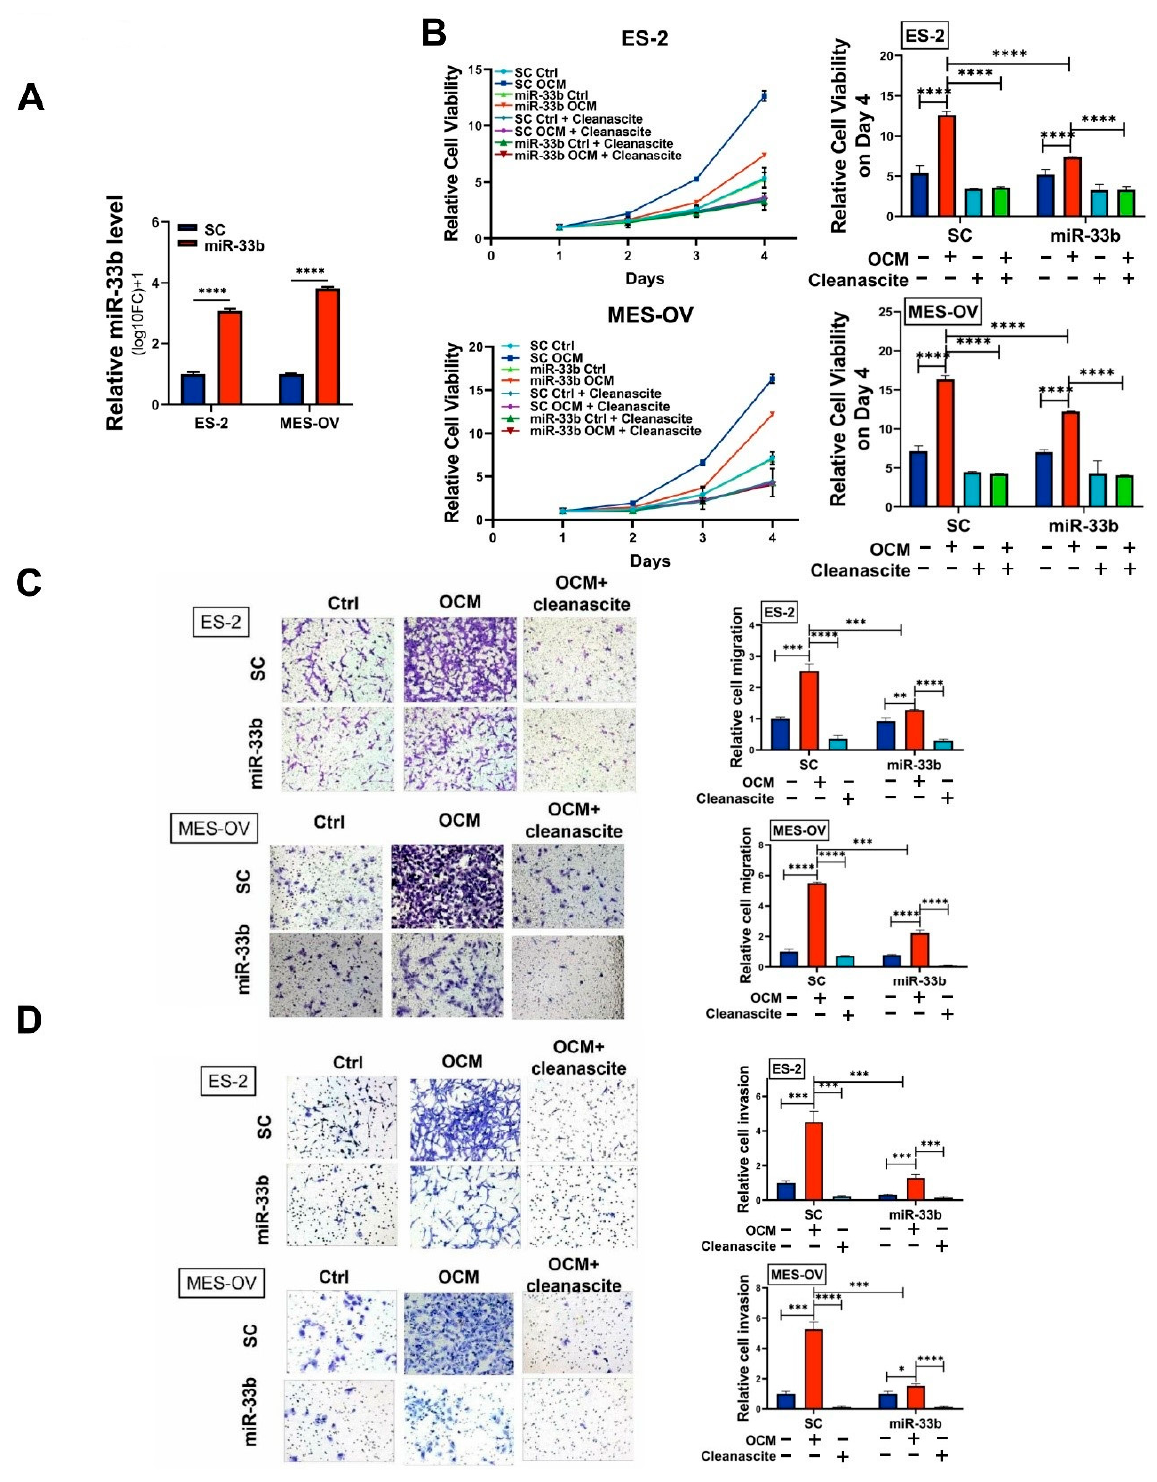
Figure 2. miR-33b abrogates oncogenic properties induced by OCM in ovarian cancer cells. ( A ) Taqman microRNA assay validated the overexpression of miR-33b in ES-2 and MES-OV cells. U6 was used as an internal control. ( B – D ) Ovarian cancer cell proliferation, migration, and invasion of stable miR-33b overexpressing or scrambled control ES-2 and MES-OV cells were examined under the treatment of control medium, omental conditioned medium (OCM) or OCM with Cleanascite (24 h for transwell migration and invasion assay). Cleanascite was applied to remove the lipids of the culture medium. Error bars denoted mean ± SD ( n = 3). (* p < 0.05, ** p < 0.01, *** p < 0.001, **** p < 0.0001). Magnification: 40×.